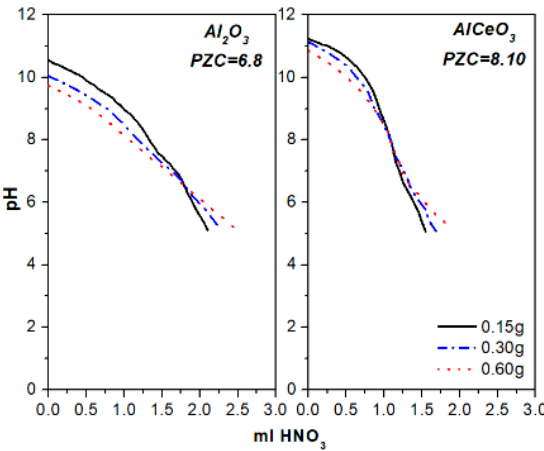
Figure 1. Potentiometric titration curves and point of zero charge (PZC) of the Al 2 O 3 and AlCeO 3 supports.